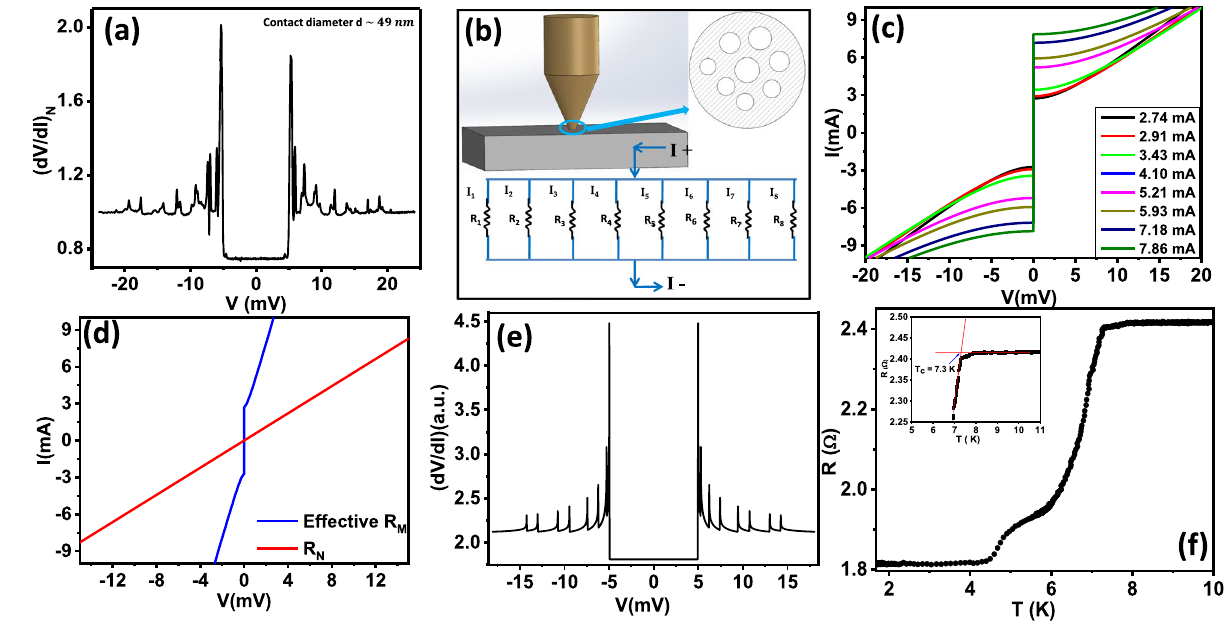
Figure 4. ( a ) Normalized differential resistance ( ( dV / dI ) N ) spectrum in the thermal regime showing the multiple critical current peaks. ( b ) Schematic of point contact setup with microconstrictions of different diameter and modelled electrical circuit in thermal regime. ( c ) I – V characteristics of Maxwell’s resistance for different values of I c . ( d ) I – V characteristics corresponding to effective Maxwell’s resistance ( R M ) (blue) and normal point contact resistance ( R N )(red). ( e ) Calculated dV / dI vs V spectrum. ( f ) Resistance ( R ) of the point contact vs. T in the thermal regime. The inset shows the method of estimation of T c